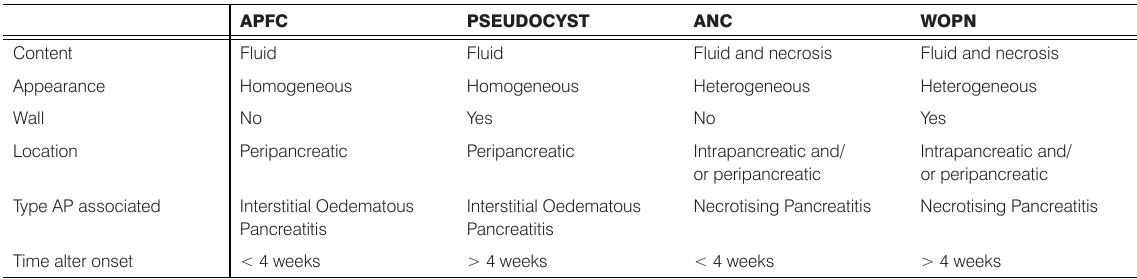
Table 2. Atlanta 2013: Fluid Collections in Acute